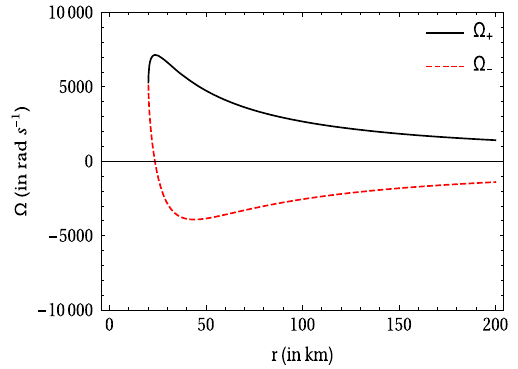
Fig. 9 Plots of the limiting values of the angular velocity of the gyro with distance from the center of a 8 M ◦ Kerr BH ( a = 0 . 7 M). The black solid curve is for prograde motion, and the red short dashed curve is for retrograde motion. The event horizon of the BH is around 20 . 3 km